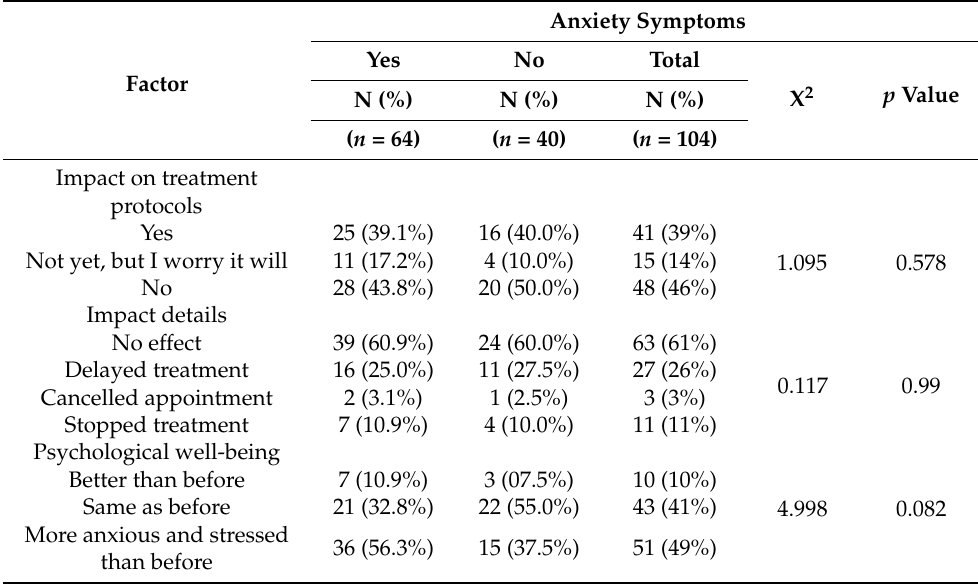
Table 3. Impact of COVID-19 in relation to anxiety ( n =